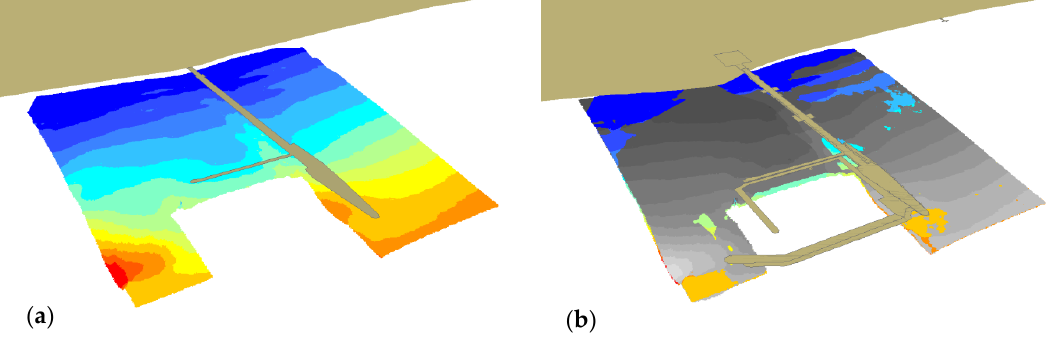
Figure 9. 3D bottom model based on the 2010 ( a ), 2010 and 2012 surveys ( b ).